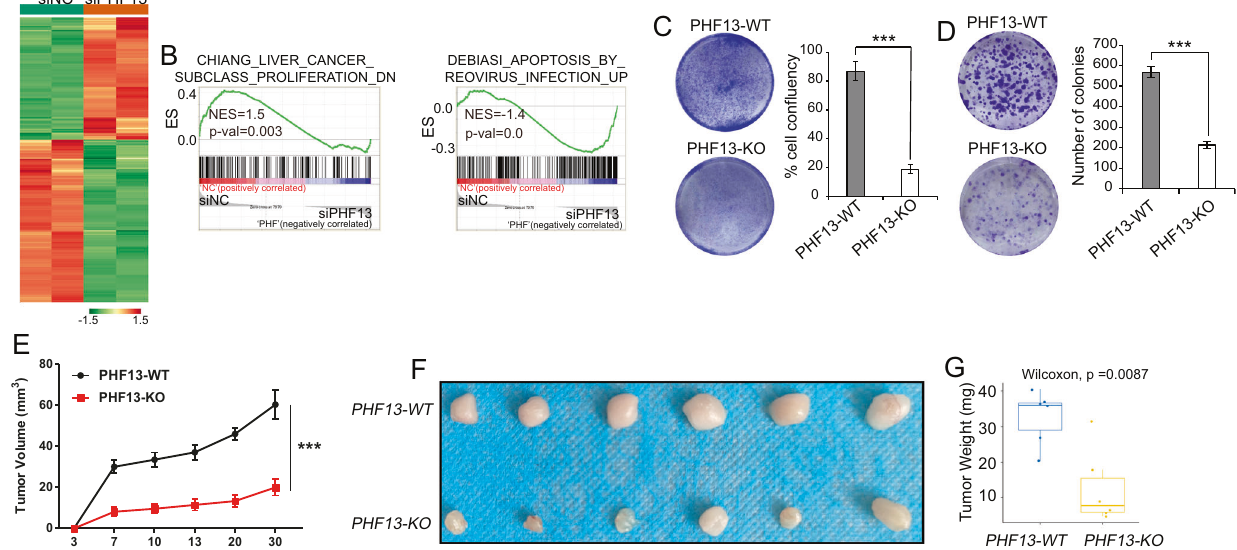
Fig. 2 Perturbation of PHF13 suppresses pancreatic cancer cell proliferation in vitro and in vivo. A Heatmap showing the differential expressed genes following PHF13 depletion in pancreatic adenocarcinoma cells Panc-1. The color key was shown at the bottom of the graph. The signi fi cantly regulated genes were selected based on : the absolute value of log2-fold change > 0.58, the p-adj < 0.05 B GSEA showing the signi fi cant enrichment of gene sets associated with cell proliferation (left panel), and apoptosis (right panel). NES, normalized enrichment score. C Cell proliferation assay for PHF13-WT and PHF13-KO Panc1. Image of crystal violet staining (left panel). The con fl uency of stained cells in each well was calculated by ImageJ (right panel). The data are shown as the mean ± SD. *** p < 0.001, calculated by two-side t test. all experiments were performed in triplicate. D Colony-forming assay for PHF13-WT and PHF13-KO Panc1 cells. The left panel indicates the image of crystal violet staining for the colonies. ImageJ was utilized to calculate the numbers of stained colonies in each well (right panel). Biological triplicate experiments were performed. The data are represented as the mean ± SD. *** p < 0.001, calculated by two-side t test. E Representative graphs showing the size of tumors formed by transplanting PHF13 -WT and PHF13 -KO Panc1 cells into the right groin of the mouse to establish an orthotopic model. Error bars represent the standard error of the mean between the six biological replicates. *** p < 0.001, calculated by two- side t test. F The pictures showed the tumors formed by transplanting PHF13-WT and PHF13-KO Panc-1 cells. The xenografts were harvested at 30 days. G boxplot showing the weight of tumors implanting PHF13-WT and PHF13-KO Panc1 cells for 30 days. P value was calculated by the unpaired Wilcoxon – Mann – Whitney